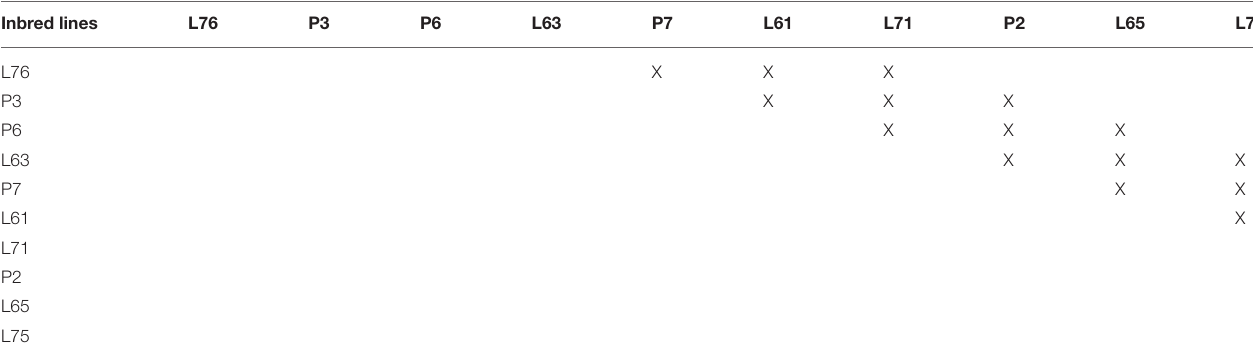
TABLE 1 | Hybrid combinations from circulating diallel across 10 popcorn inbred lines with crosses ( s ) = 3. Inbred